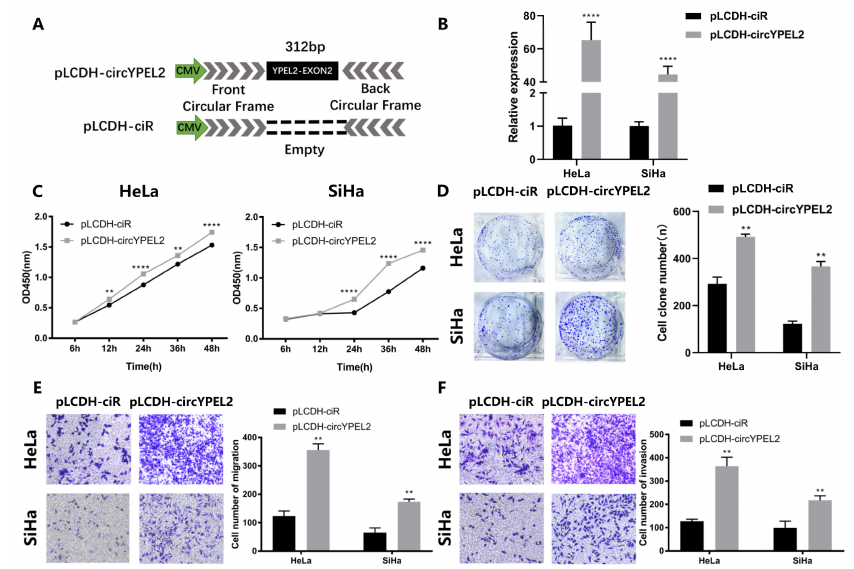
Figure 4. Overexpression of circYPEL2 promotes cell proliferation, migration and invasion. ( A ) Schematic illustration of the expression vector of circYPEL2. ( B ) Expression levels of circYPEL2 and YPEL2 mRNA in HeLa and SiHa cell lines transfected with the pLCDHircYPEL2 vector. The pLCDH-ciR vector was the negative control. ( C ) CCK-8 assays in HeLa and SiHa cell lines to detect cell viability at 0, 6, 12, 24, 36 and 48 h. ( D ) Clone formation assays in HeLa and SiHa cell lines to detect cell proliferation. ( E , F ) Transwell assay for cell migration and invasion ability in HeLa and SiHa cells. (Mean ± SD of three experimental replicates are presented. ** Represents p < 0.01, **** represents p < 0.0001).